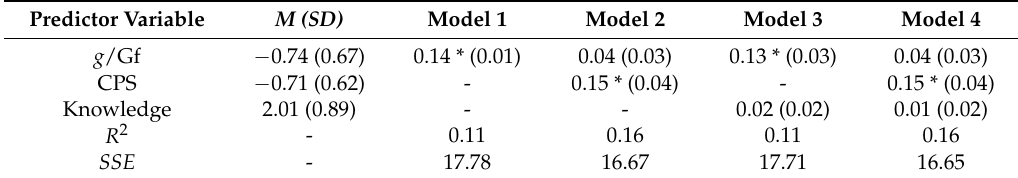
Table 4. Regression models for Job Zone 2 (DV: natural log median annual wages, ln).